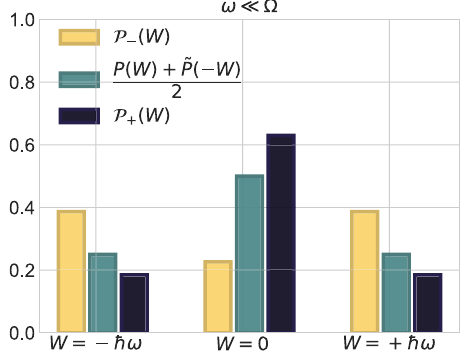
Fig. 4 Work probability distribution for a spin-1/2 system in a superposition of forward and time-reversal processes. The coherent work probabilities P ð W Þ and the work probabilities of a classical mixture (cid:5) (cid:6) ± P ð W Þ þ ~ P ð(cid:2) W Þ = 2 are compared in the limit of the rapid quench ω ≪ Ω for φ = π . The results